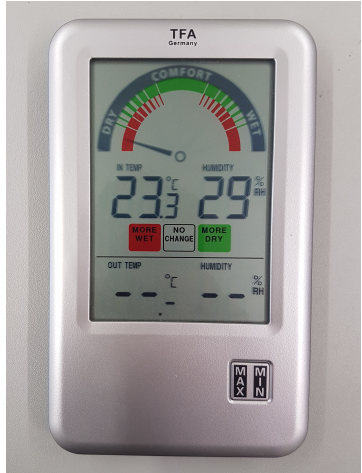
Figure 18. Case of a thermometer used to validate the proposed sensor models. The case consists of different surfaces with different reflectance properties.